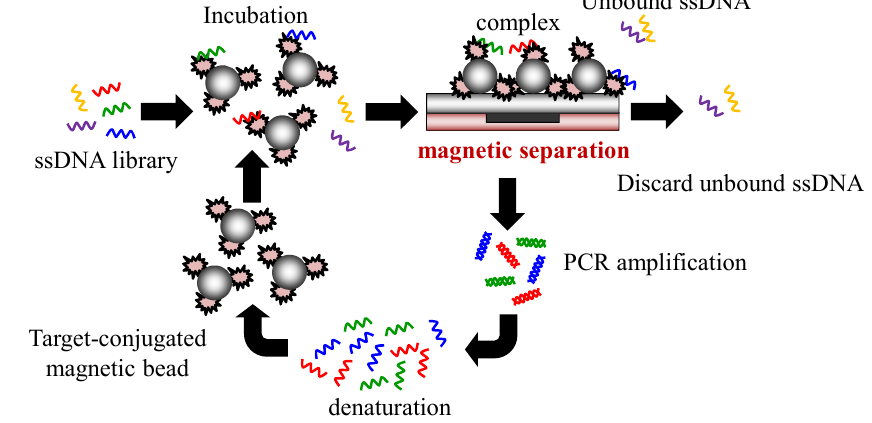
Figure 3. Schematic illustration of the SELEX processes in magnetic-bead-based microfluidic chips. The microfluidic selection process begins with the incubation of random ssDNA library with target proteins conjugated to magnetic beads. After incubation, the partitioning step to separate the target-bound aptamers from the unbound nuclear acids is performed in the microfluidic chip. Stringent washing conditions then are imposed in the microchannel to continuously elute weakly- and unbound nuclear acids from the microfluidic chip. After the separation, the external magnets are removed, and the beads carrying the selected aptamers are released from the device. The entire separation process with trapping, washing, and bead elution performs on chip. Finally, the selected aptamers are amplified via